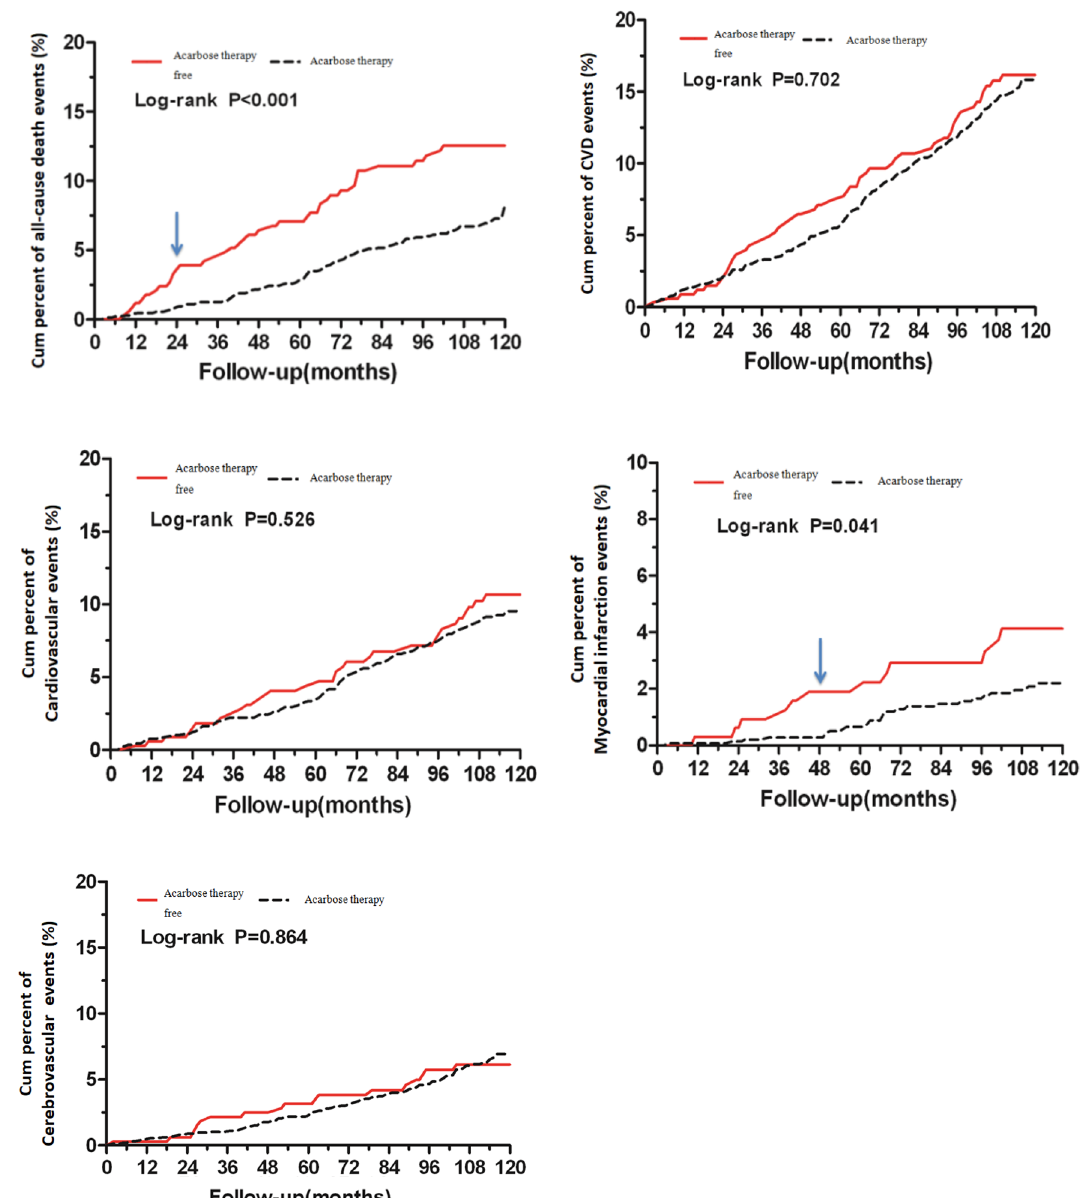
Figure 1. A correct version of the original Figure